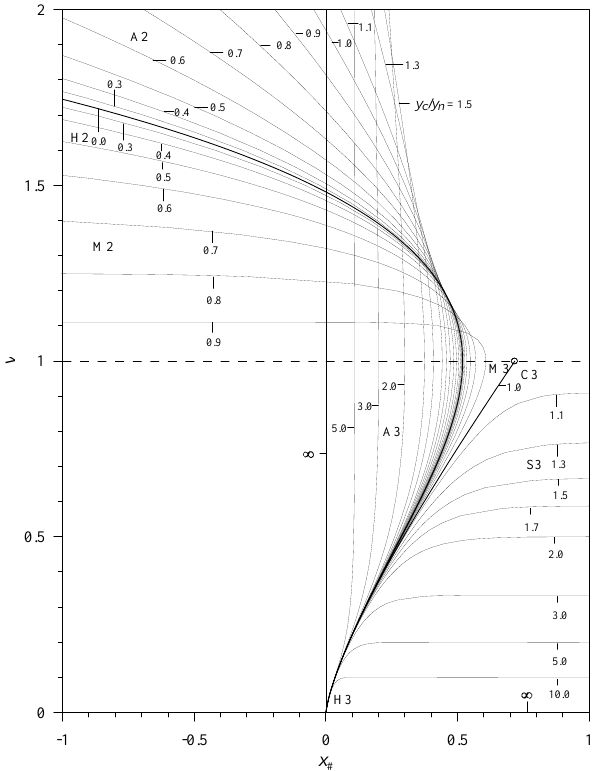
Fig. 2. A close-up of those H, M, C, S and A profiles which are plotted in Fig. 1 around the boundary condition at ( x # , v) = ( 0 , 0 )